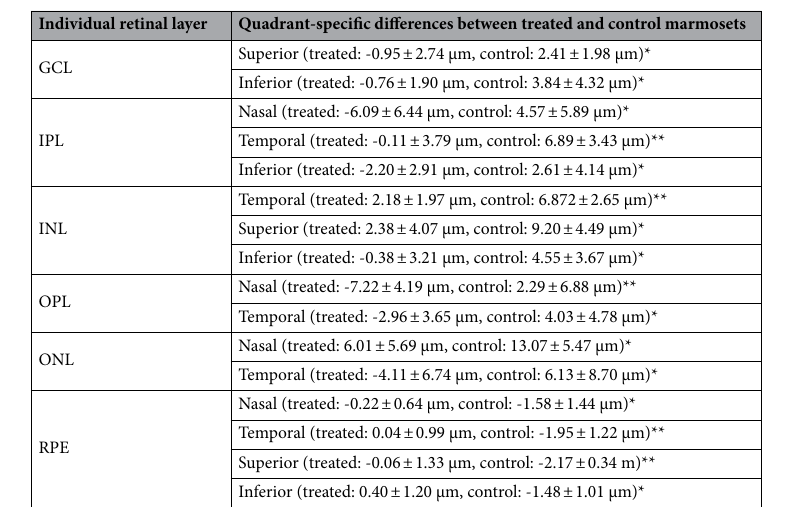
Table 1. Retinal quadrant-specific differences in the individual retinal layer thicknesses (mean ± SD) between the treated and control marmosets. * p < 0.05; ** p < 0.01.